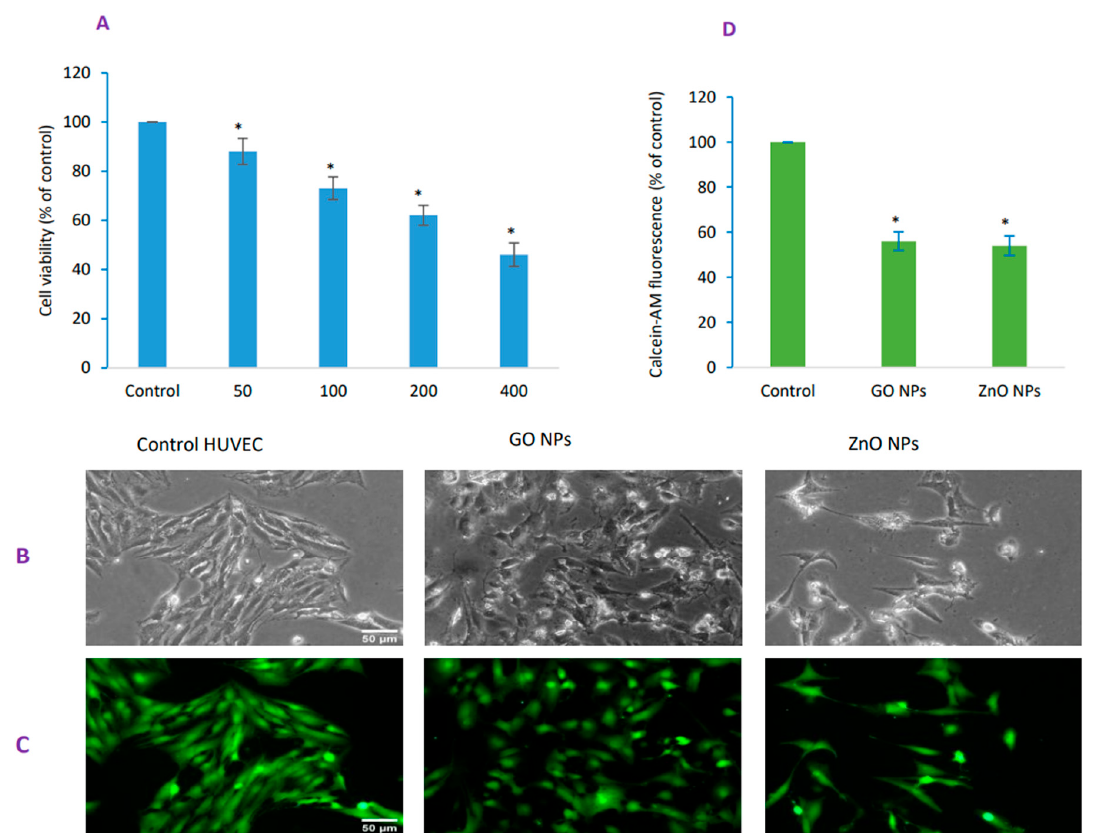
Figure 2. Potential cytotoxicity in human umbilical vein endothelial cells (HUVECs) due to GO NPs